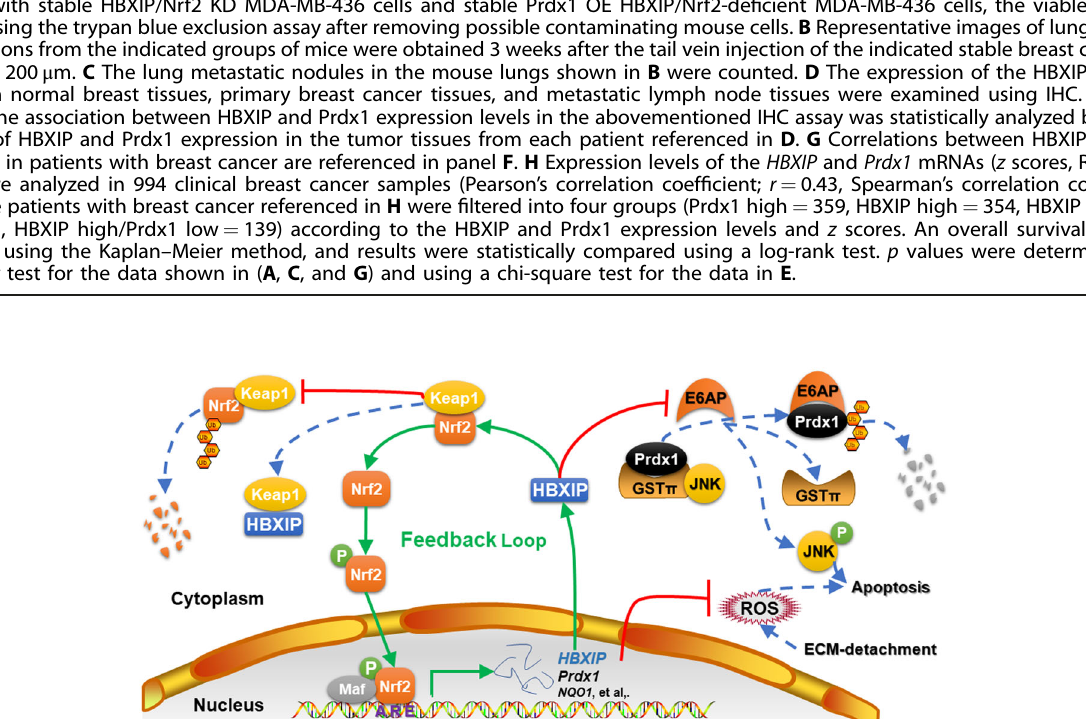
Fig. 7 Summary model of the reciprocal HBXIP/Nrf2 feedback loop in breast cancer cells. HBXIP induces anoikis resistance in breast cancer cells by forming a reciprocal positive feedback loop with Nrf2 to maintain redox homeostasis, inhibiting JNK1 activation by preventing Prdx1